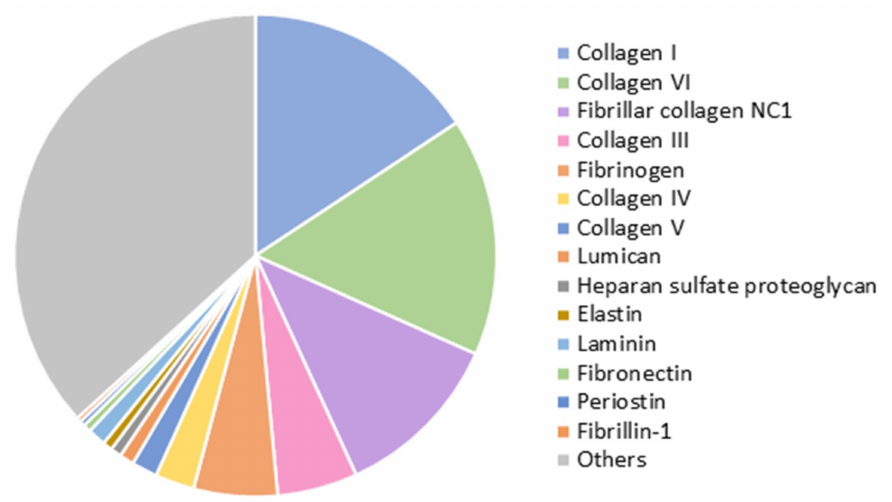
Figure 1. Proteins identified by liquid chromatography–tandem mass spectrometry (LC–MS/MS) in the lyophilized cardiac extracellular matrix (cECM) ( n =